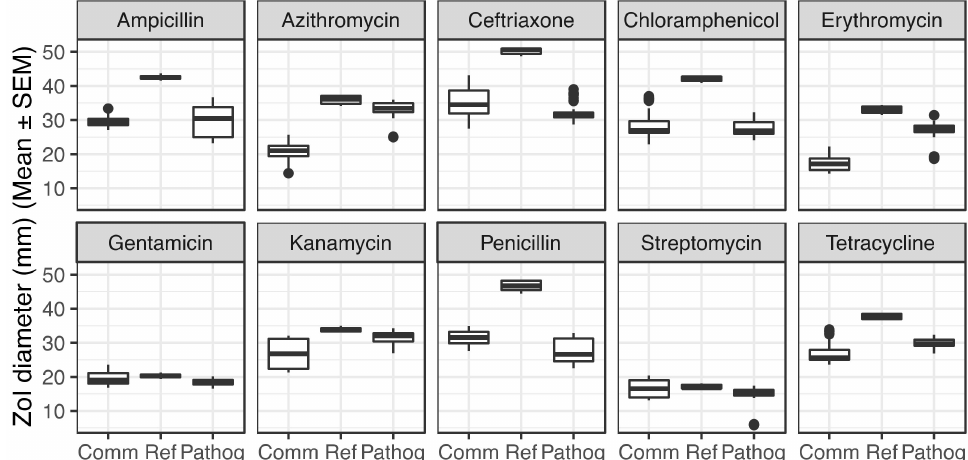
Figure 2. Zones of inhibition diameters (in mm) per group of species, comparing all commensals (Comm) to the reference strain N. gonorrhoeae FA19 (Ref), and to the group of resistant and pathogenic N. gonorrhoeae strains MS11, F89, and H041